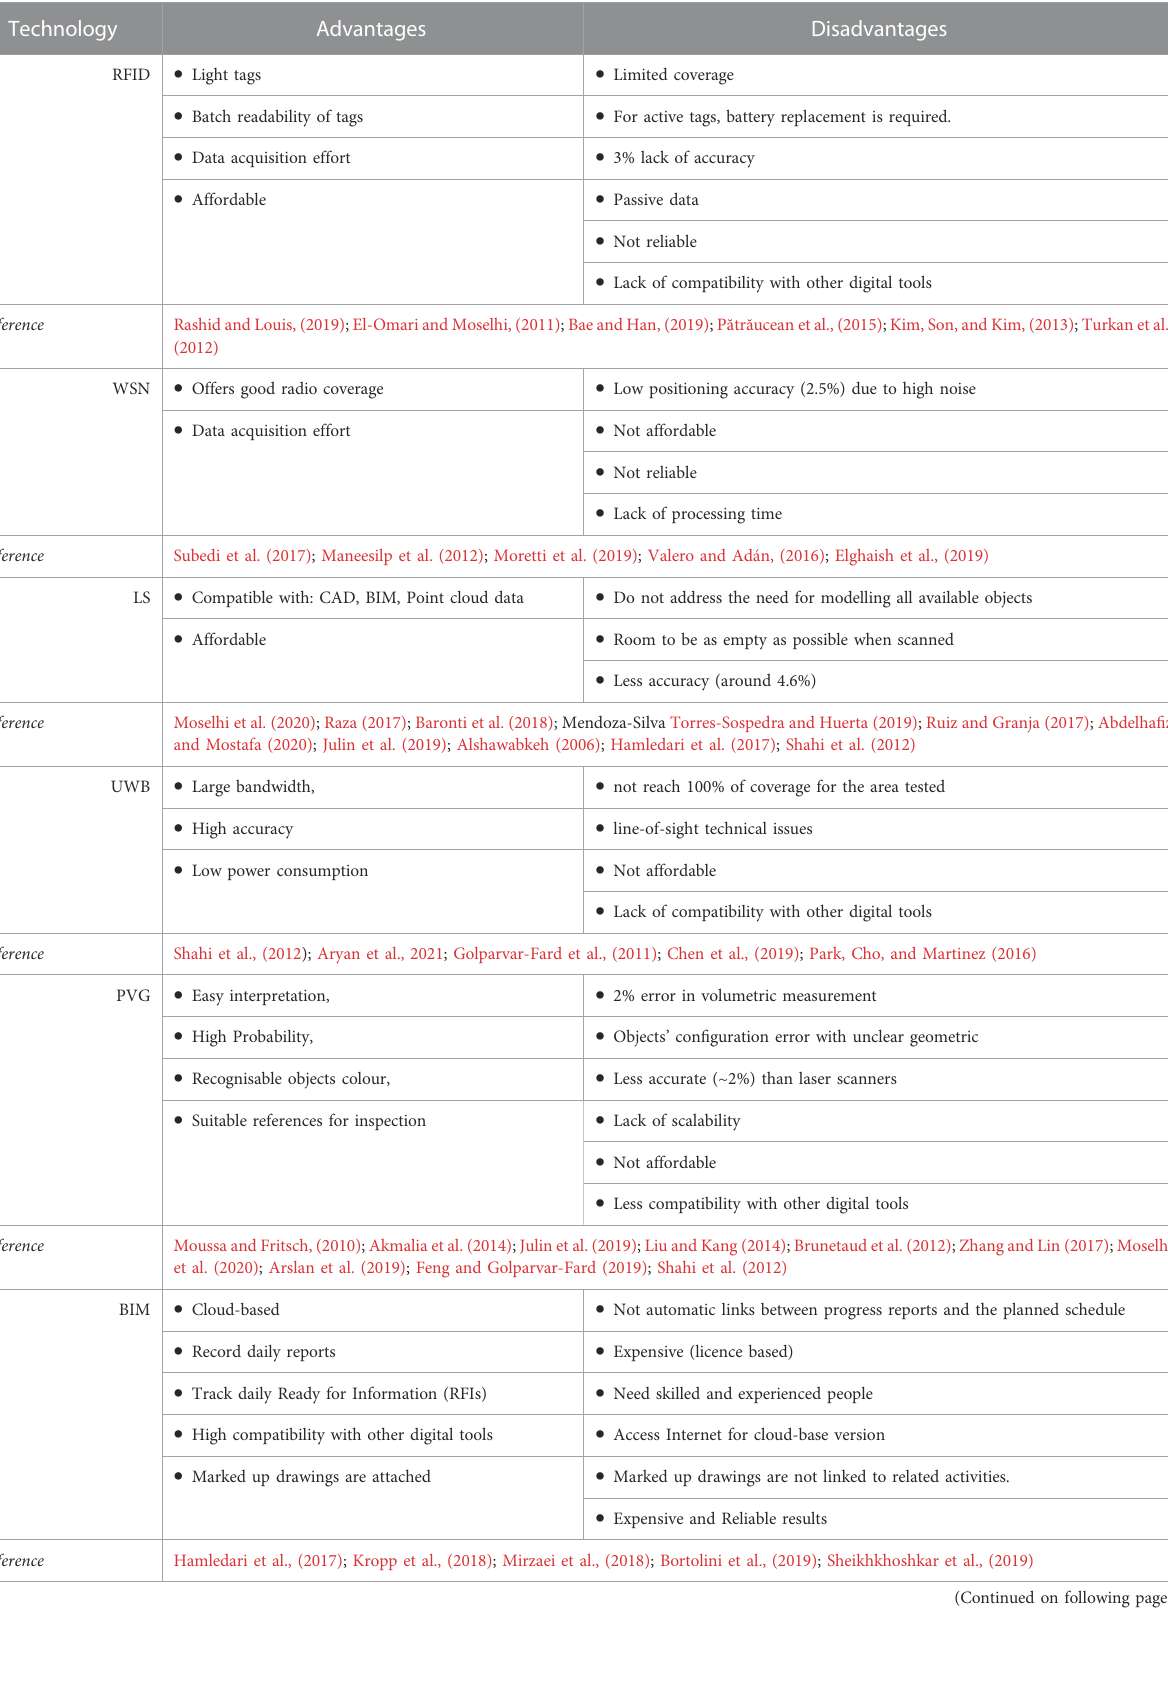
TABLE 8 Key advantages and disadvantages: single digital